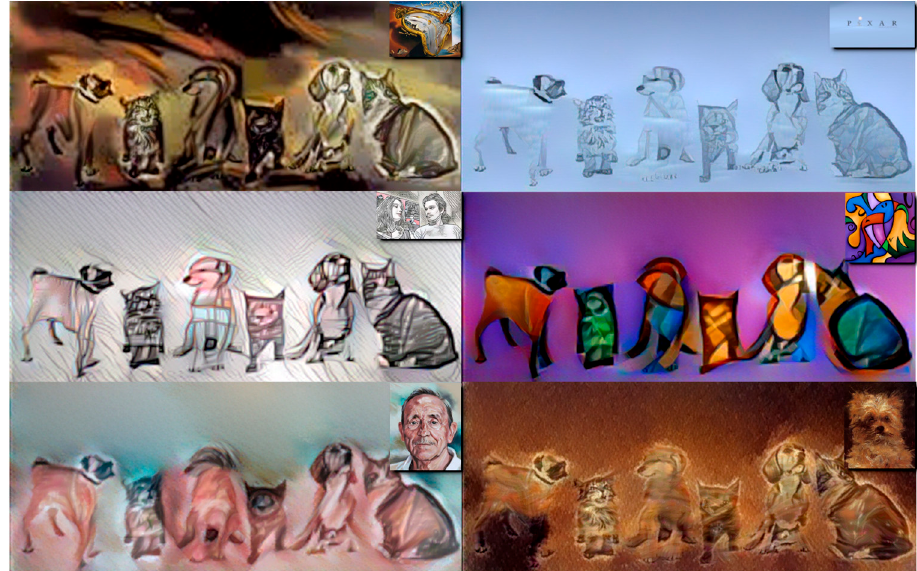
Figure 4. Results of the proposed method, applied to the “cats and dogs” image, for various style images.